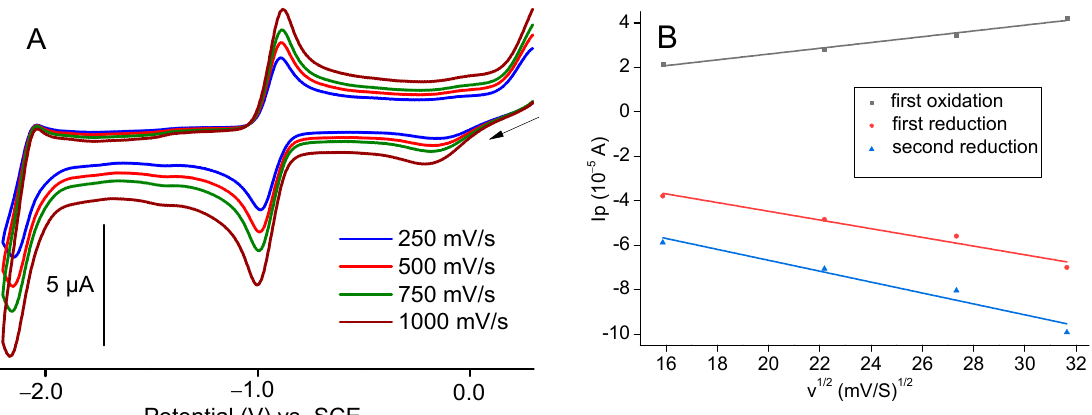
Figure 4. Cyclic voltammograms of [Co(TMFPP)] in 0.1 M n Bu 4 NBF 4 /DMF recorded at different scan rates ( A ). Peak currents vs. square roots of the scan rate for the two reduction processes ( B